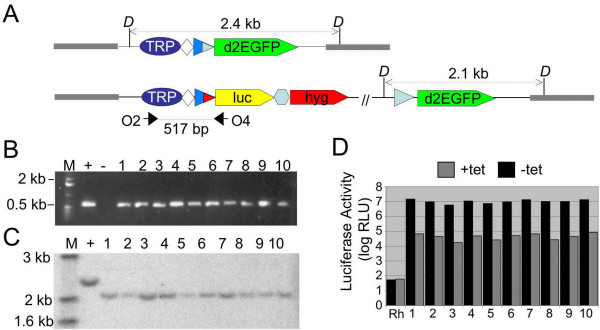
Cre-mediated insertion by ScIn-1. A. Schematic (not to scale) of the target locus in clone Rht14-19 before (top) and after (bottom) Cre-mediated insertion of pIN-1. DNA is represented as in Fig. 1 with recognition sites for DraI (D) and PCR primers indicated. B. Ethidium bromide stained agarose gel of electrophoresed PCR products generated with the primers in A, and pTIGHTluc (Clontech) DNA (+), no DNA (-) or cell pellets of 10 hygr, GFP-negative clones (1–10) selected after transfection of Rht14-19 with pIN-1 and pMC-Cre. M= marker DNA. C. Southern blots of genomic DNA isolated from Rht14-19 (+) and the same Rht14-19 derivatives described in B digested with DraI. The probe was from the d2EGFP cassette. M = marker DNA. D. Luciferase activity in lysates from Rht14-19 (Rh) or the same Rht14-19 derivatives (1–10) described in C, grown in the absence or the presence (for 48 h.) of tet.